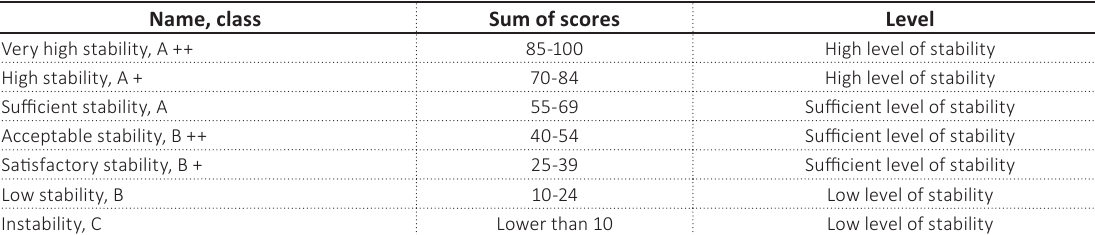
Table 6. Rating scale of stability of production and trading